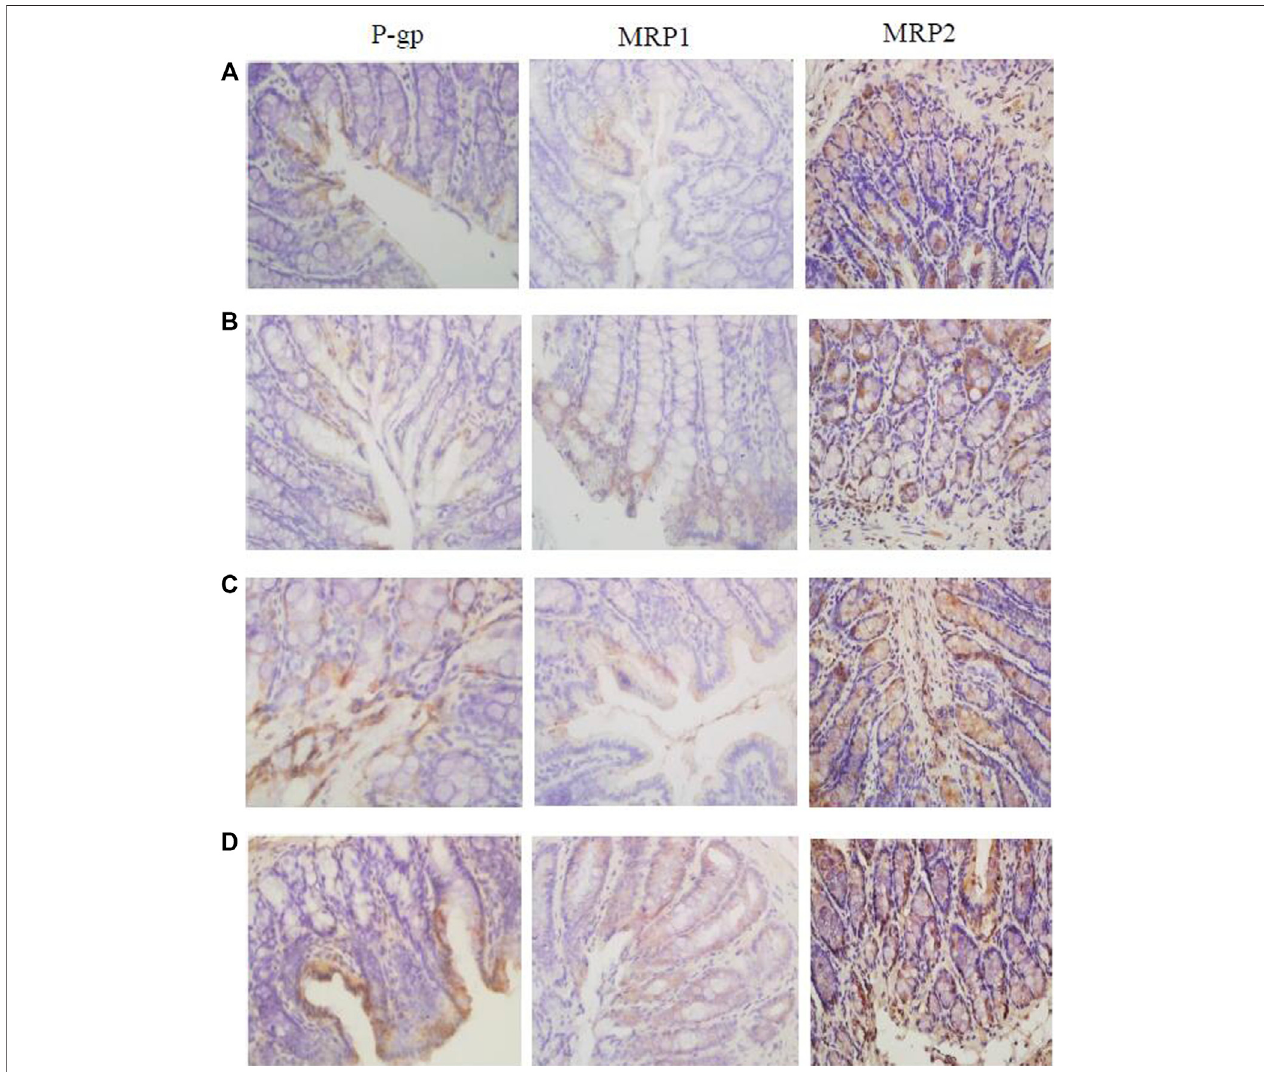
FIGURE 7 | The expression of P-gp, MRP1, and MRP2 in the rats colon [ (A) : normal; (B) model; (C) multiple dose of WJW in normal; (D) multiple dose of WJW in model].